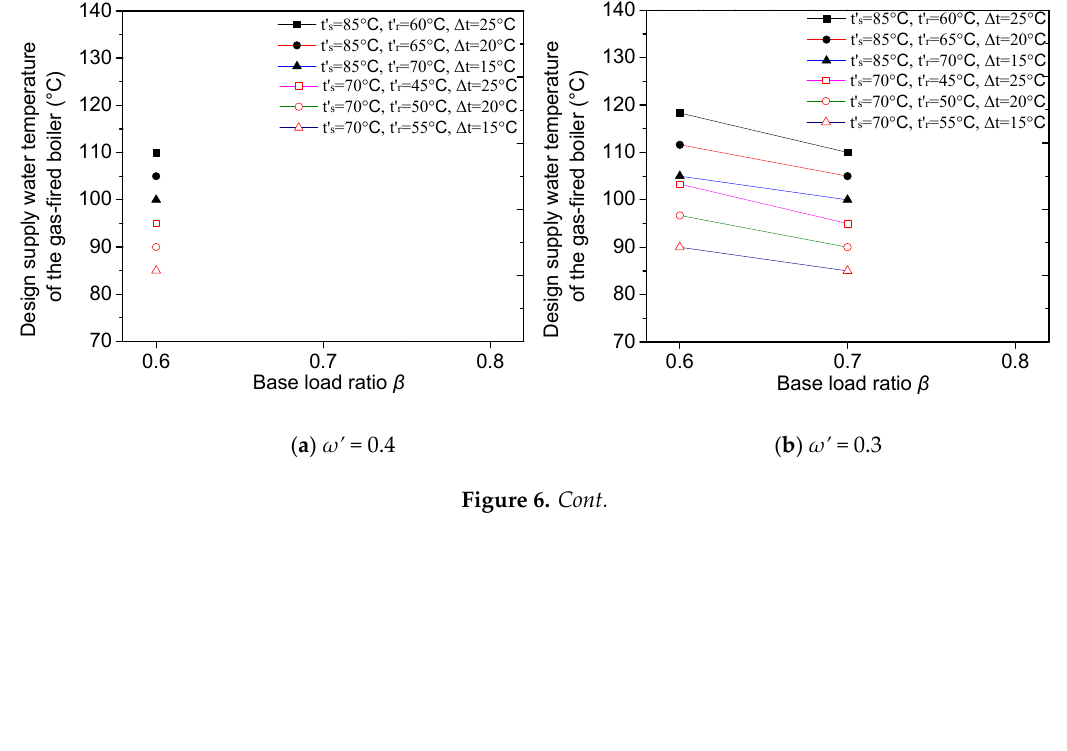
Figure 5. Variation of the design supply water temperature of the heat exchanger ( 𝑡 (cid:3046),(cid:3035)(cid:3045), ) with different network temperature levels, base load ratio ( β ) and design peak shaving flow ratio ( ω ’ ) for parallel